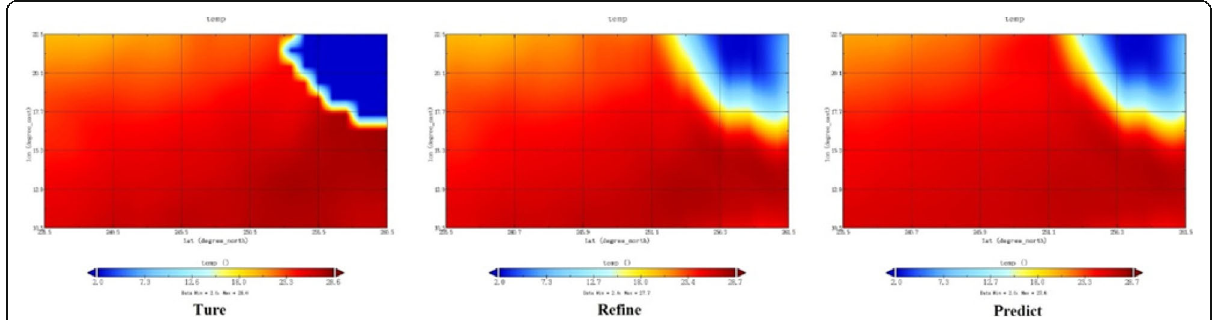
Fig. 5 Comparison for temperature distribution of real data, high-resolution data, and prediction results on February 2016